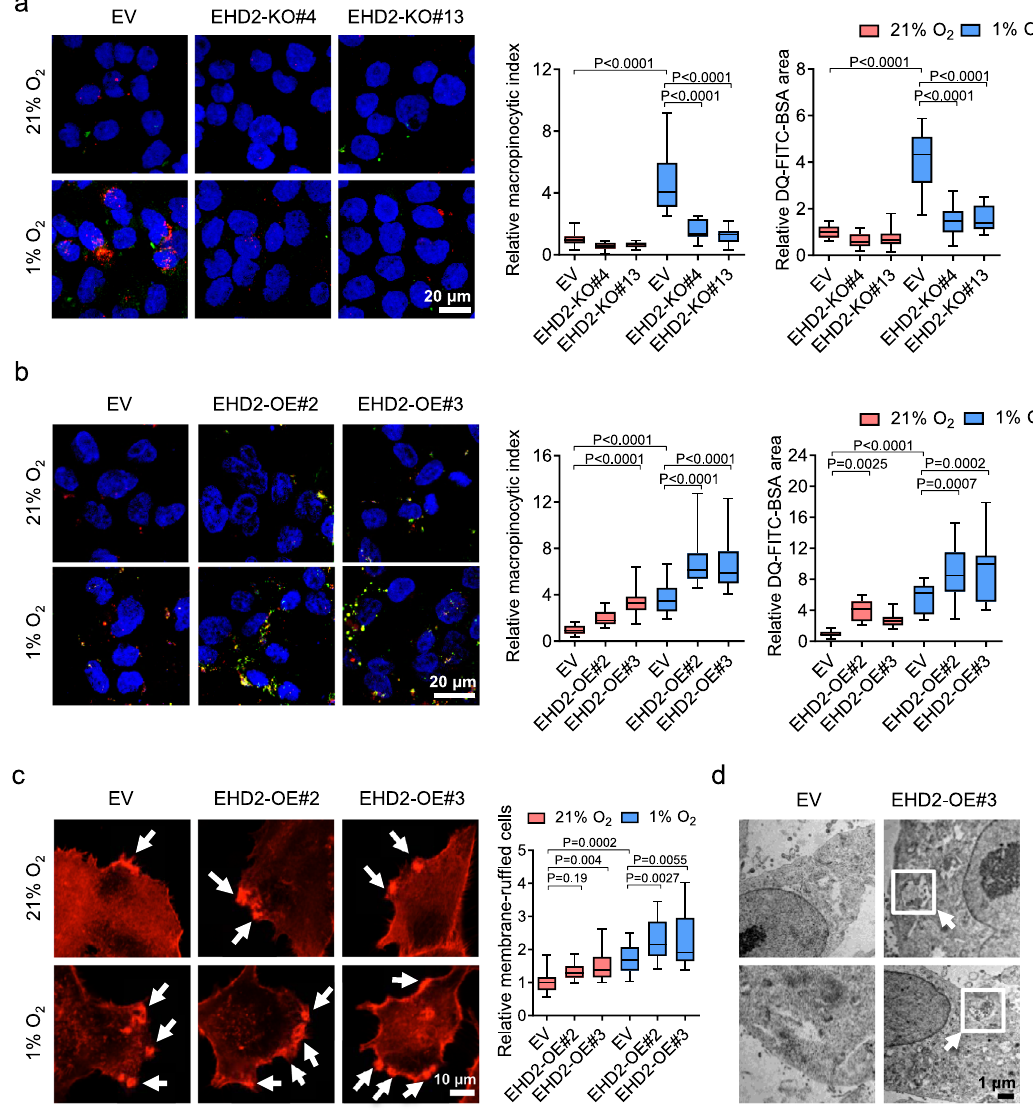
Fig. 4 EHD2 promotes macropinocytosis through actin remodeling. a . Confocal images show dextran uptake/macropinosomes (red) and FITC-BSA degradation (green) of MHCC97L-EV, -EHD2-KO#4, and -EHD2-KO#13 exposed to 21 and 1% O 2 . b Confocal images reveal dextran uptake/ macropinosomes (red) and FITC-BSA degradation (green) of MHCC97L-EV, -EHD2-OE#2, and -EHD2-OE#3 cells exposed to 21 and 1% O 2 . c Super high- resolution images show actin fi laments (phalloidin, red) in MHCC97L-EV, -EHD2-OE#2, and -EHD2-OE#3 cells exposed to 21 and 1% O 2 . Arrows indicate the membrane ruf fl es. Percentage of cells with membrane ruf fl es was normalized to 21% O 2 EV. d Images acquired by transmission electronic microscope (TEM) in MHCC97L-EV and -EHD2-OE#3 cells exposed to 21% O 2 . Arrows point to the macropinosomes in MHCC97L-EHD2-OE cells. a , b Macropinocytic indexes and DQ-FITC-BSA particle areas were normalized to 21% O 2 EV. a – c Results were from 3 independent experiments. d Results were representative from n = 5 imaging analysis. Scatter plot: center line, mean. Box-and-whisker: center line, median; box limits, 25th to 75th percentiles; whiskers, min to max. Two-way ANOVA with Bonferroni correction. Source data are provided as a Source Data fi fi laments 17 . The membrane ruf fl es take the form of planar lamellipodia, circular cup-shaped membrane extensions (circular ruf fl es), or blebs 28 . Membrane ruf fl es occasionally curved into an open, crater-like cups of plasma membrane, named as “ macro- pinocytic cup ” 17 (Supplementary Fig. 12a). OE of EHD2 promoted the formation of membrane ruf fl es (Fig. 4c), while KO of EHD2 reduced the membrane ruf fl es in MHCC97L cells (Supplementary Fig. 12b). EHD2 has been shown to interact with actin fi lament through binding of different partners as EHBP1 and NEK3 39,41 , we asked if the interactions of EHD2 and its binding partner are indispensable for initiation of macropino- cytosis. We therefore knocked down EHBP1 or NEK3 in 0.5 – 10 μ m in diameter 28 .